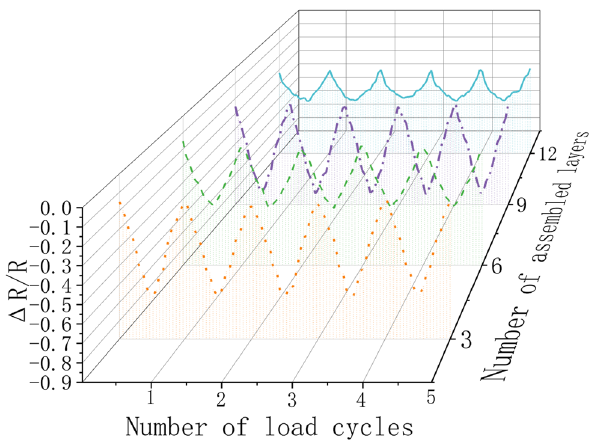
Figure 6: Relationship between change rate of resistance and mid - spandisplacement ofvaried double - layer CNTFS incompression side.